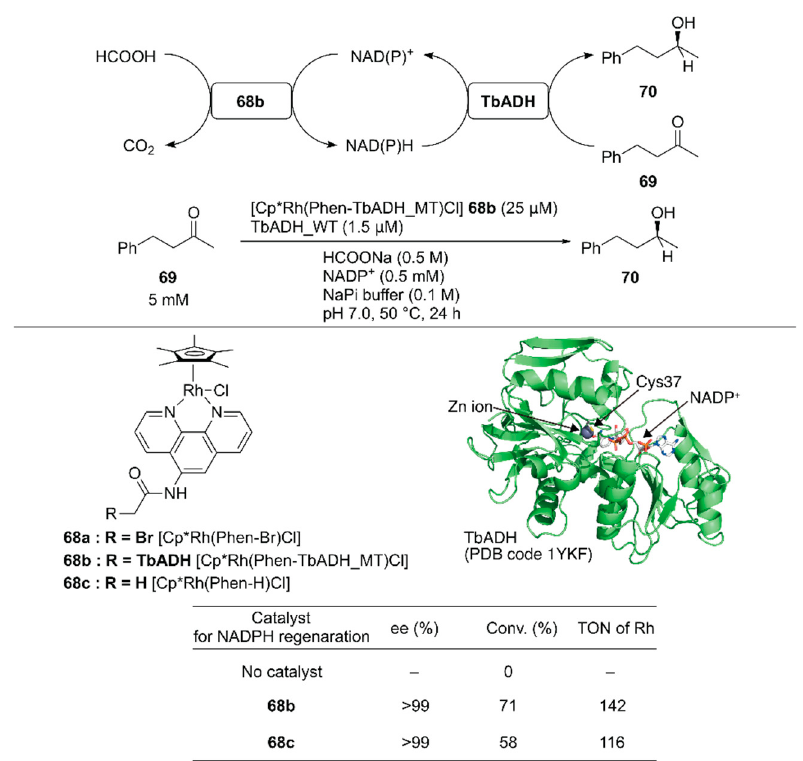
Figure 14. Reduction of 4-phenyl-2-butanone 69 by TbADH-based ArM 68b coupled with TbADH. Adapted from [102].